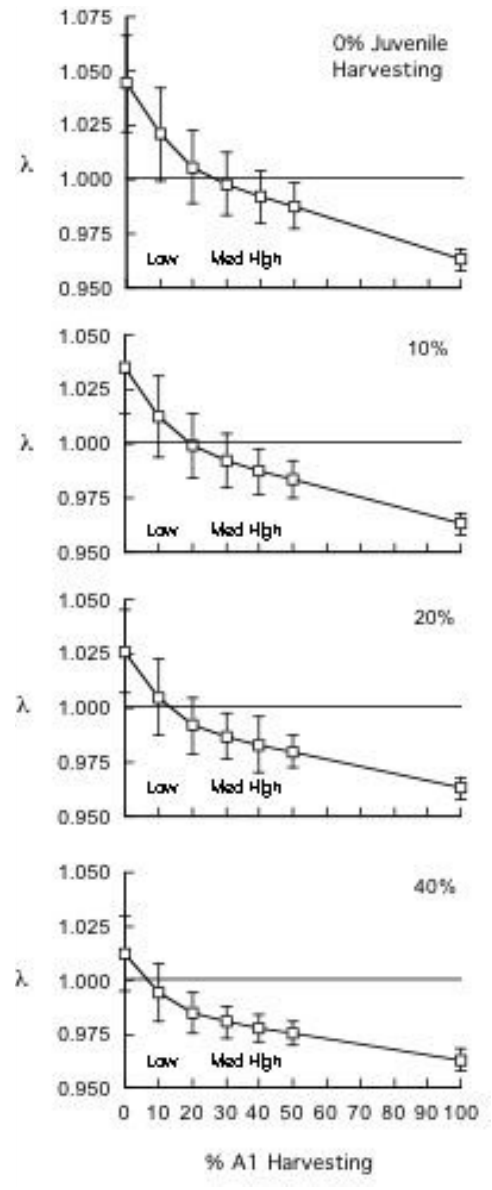
Fig. 6. Simulated effect of 0–100% A1 harvesting on the population growth rate, l , including a sensitivity analysis of the effects of harvesting between 0–40% of juveniles. Values are the mean and 95% confidence intervals (CIs) of 2000 bootstrap simulation runs. The Low, Medium, and High harvesting intensities are labeled. Harvesting levels with mean l values below 1, but with 95% CIs that range above 1, are considered to be sustainable. With no juvenile harvesting, up to 40% of A1 individuals can be harvested sustainably. If 10% of juveniles are harvested, A1 harvesting should be limited to about 30%. A 20% annual rate of juvenile harvesting means only 20% of A1 trees should be harvested. A 40% rate juvenile extraction should limit A1 harvesting to